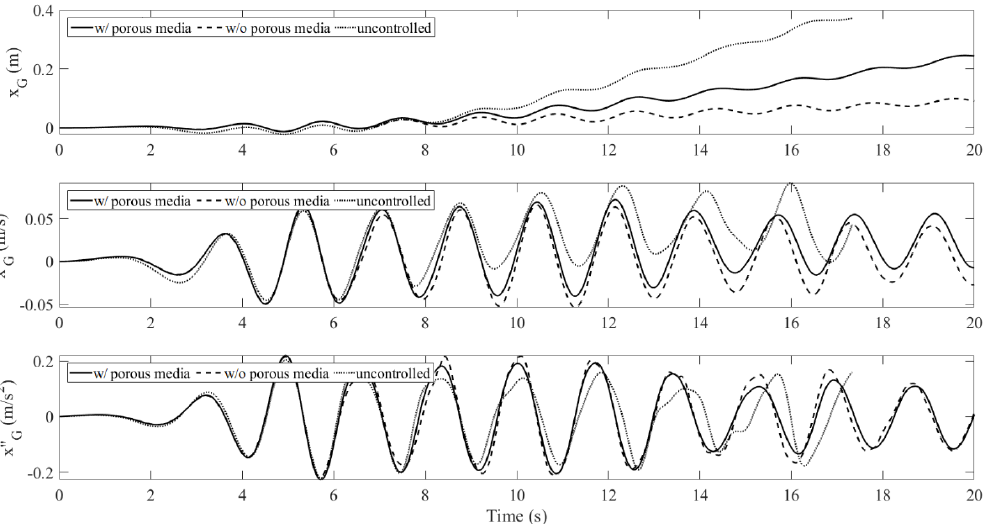
Figure 23. The surge responses of the controlled and uncontrolled floating bodies subject to large wave excitation.